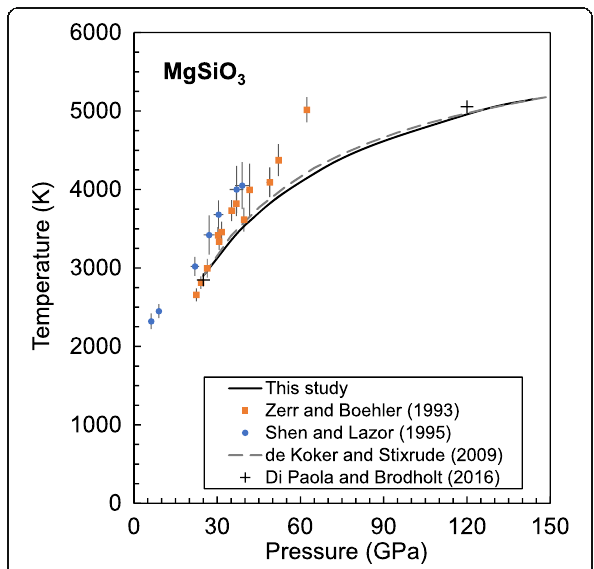
Fig. 2 Melting temperatures of MgSiO 3 . The black line represents the melting temperatures calculated in this study, the crosses by Di Paola and Brodholt (2016), and the dashed gray line by de Koker and Stixrude (2009). The melting temperatures determined by high-pressure experiments are also plotted: orange squares, Zerr and Boehler (1993); blue circles, Shen and Lazor (1995)